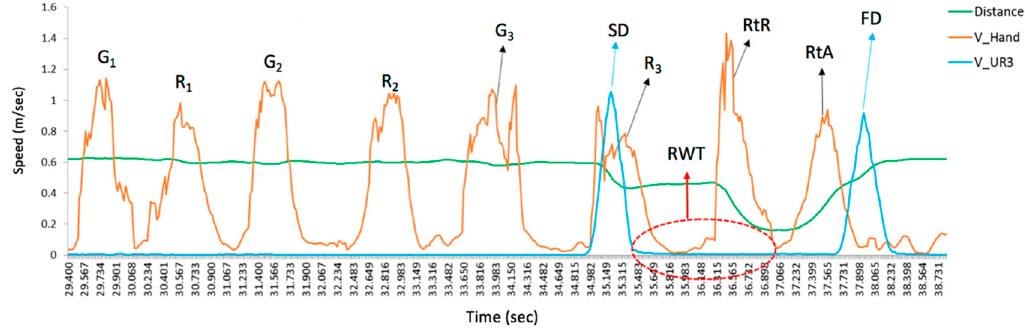
Figure 4. Robot waiting time (RWT) in the assembly cycle. Abbreviations: see caption of Figure 3.